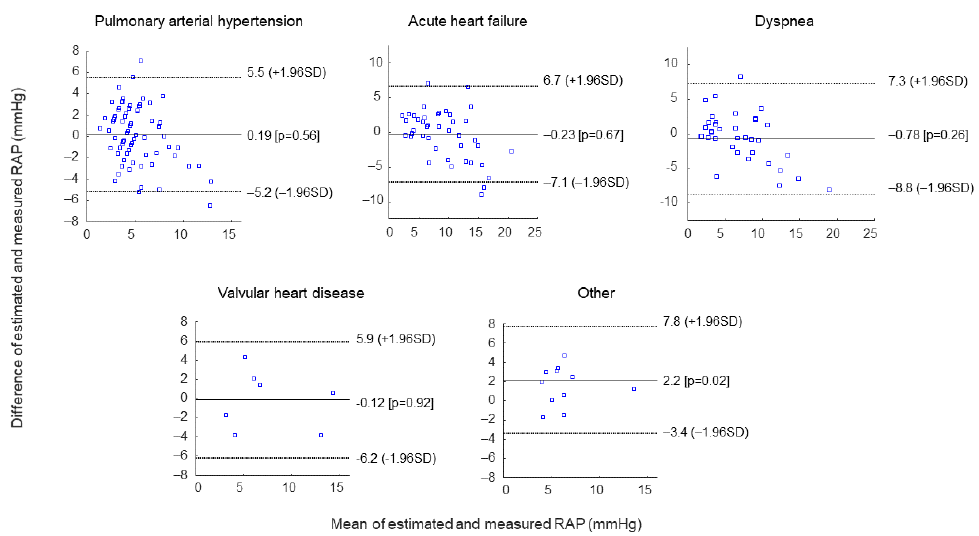
Figure A1. Bland–Altman plots comparing estimated (by LM) and measured RAP on our dataset split into different groups of